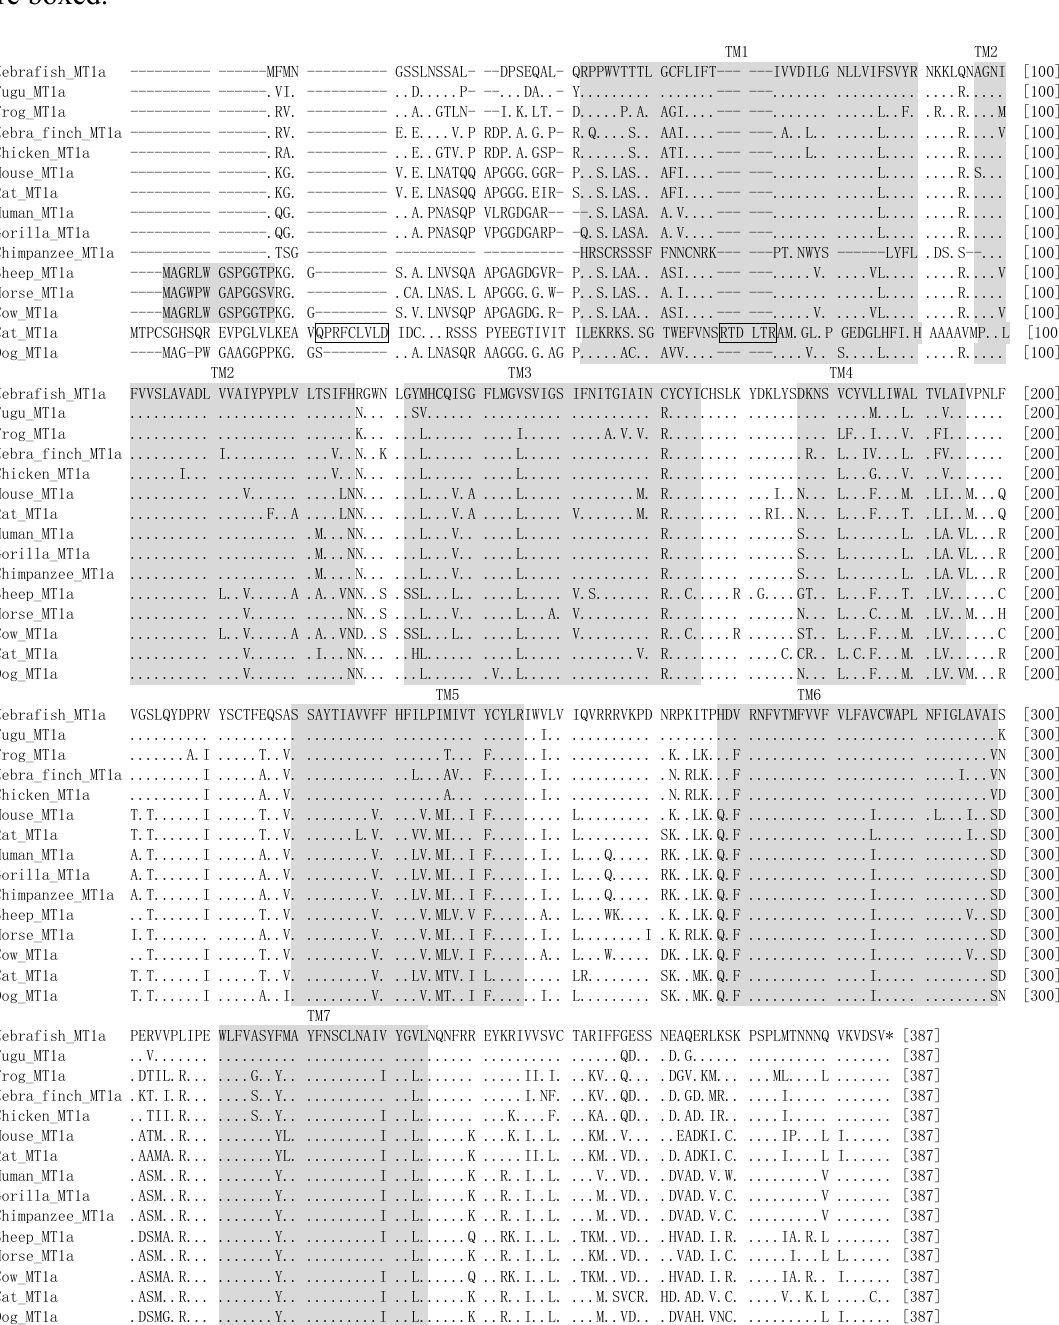
Figure 2. Sequence alignment of amino acids (AA) encoded by vertebrate MTNR1A ; ‘.’ indicates the same AA, ‘-’ indicates an AA deletion. Two insertions of cat AA sequence are boxed.